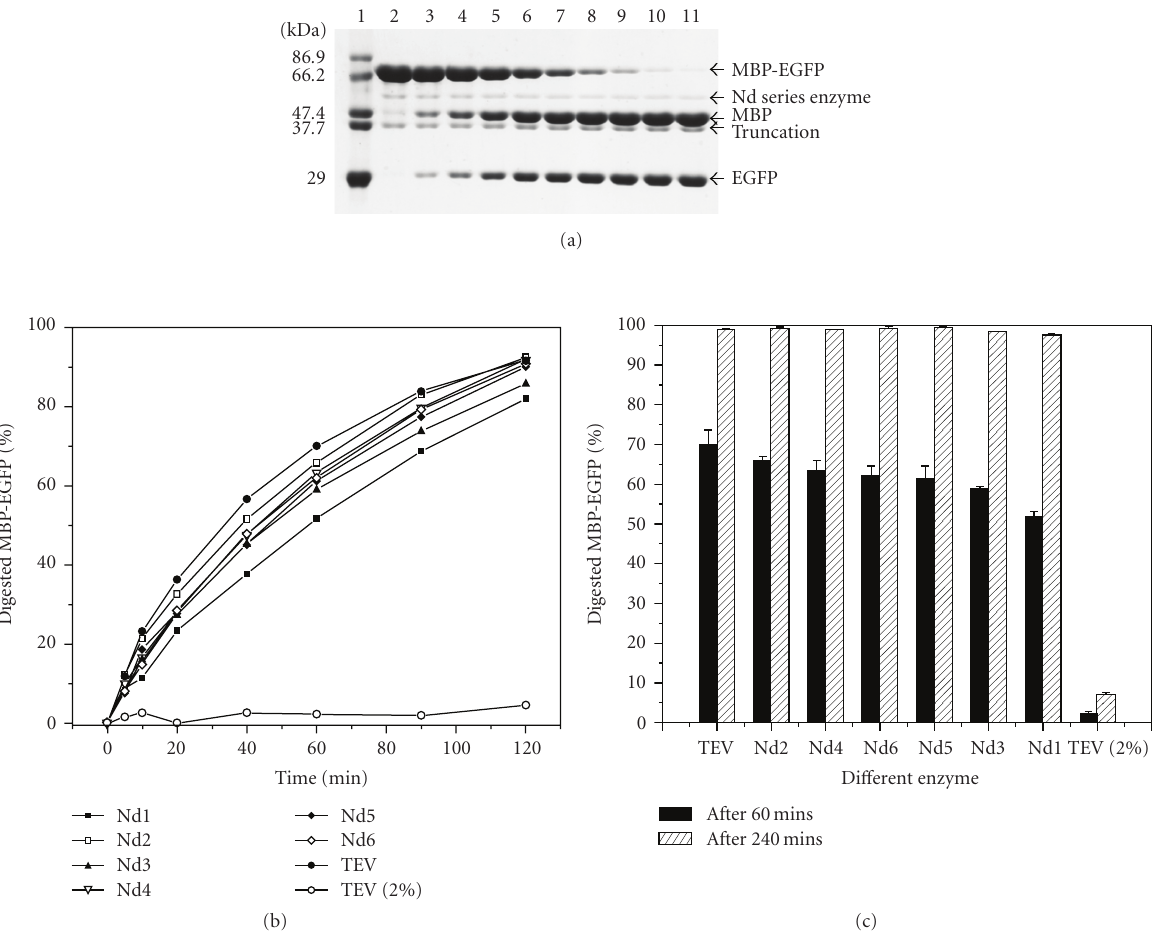
Figure 3: SDS-PAGE and time course analysis of catalytic activity on MBP-EGFP of sf GFP-TEV-His 6 and TEV-His 6 . (a) One representative of SDS-PAGE analysis. 100 μ g MBP-EGFP was incubated with 2 μ g sf GFP-TEV-His 6 Nd2. Lane 1 is the protein marker. Lanes 2–11 represent di ff erent incubation time (0, 5, 10, 20, 40, 60, 90, 120, 180, 240 minutes, resp.). (b) The time course curve analysis. The time course curve was plotted according to the quantitative analysis of the SDS-PAGE by Bandscan 4.30. Each data point was the average of three independent tests. (c) Bar representation based on time course curve. The black bars represent the percentage of the digested MBP-EGFP after incubation for 60 minutes. The striped bars represent the percentage after incubation for 240 minutes. The ranking of the bar is based on the sorting result of cleavage e ffi ciency after incubation for 60 minutes. The height of the bar is the average of three independent tests with standard error on top of the